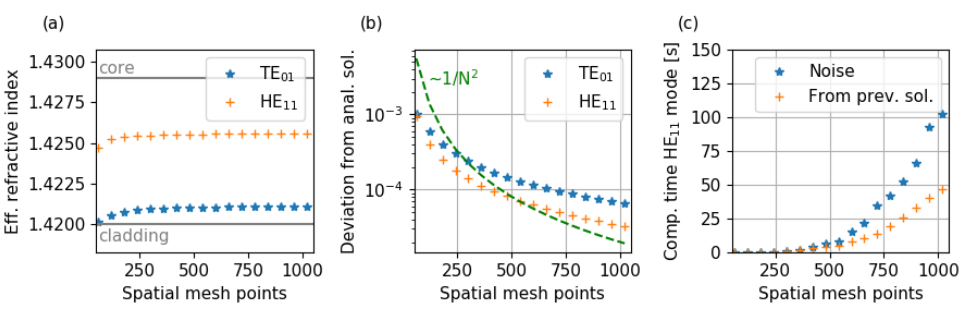
Figure 2. Results of the DHT-based mode solver regarding the HE 11 and TE 01 modes of a step-index fiber design. ( a ): Computed effective refractive indices for a varying number of spatial mesh points i.e., Fourier–Bessel coefficients. ( b ): Deviation of the computed effective refractive indices with respect to their analytically computed counterparts. ( c ): Typical required time to compute the HE 11 mode and its propagation constant, either with a noisy guess for each call of the solver or a recycled and correspondingly interpolated guess from the previous call. The dashed 1/ N 2 trend line is not fitted but only a guide to the